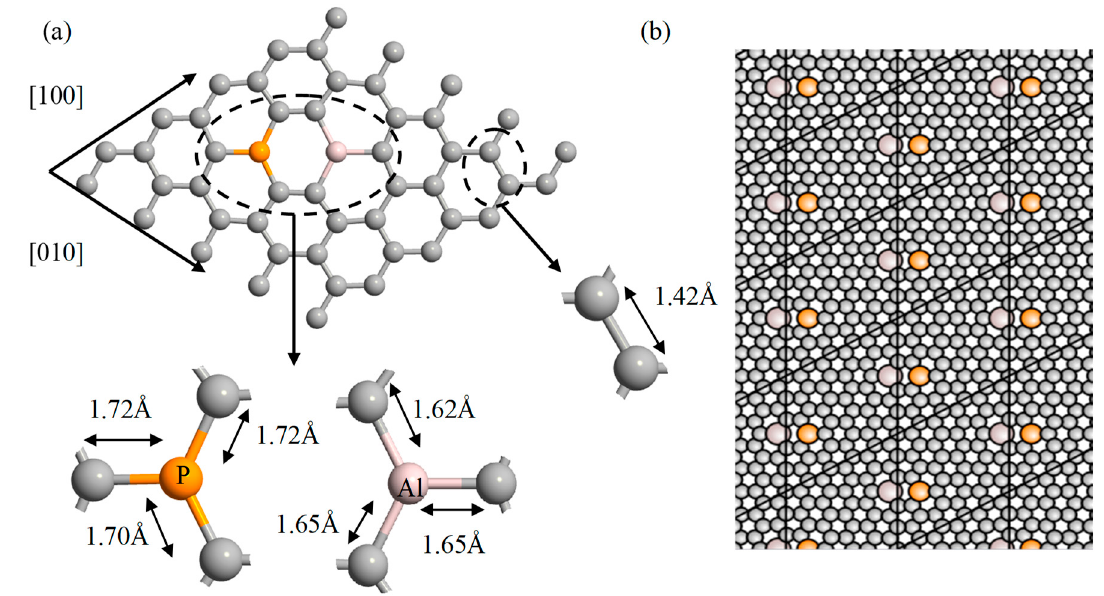
Figure 2. Ground-state optimal structure of Al-P doped graphene; ( a ) optimized bond lengths of Al—C, P—C, and C—C; ( b ) extended structure of co-doped graphene considered for the energy band structure calculations.